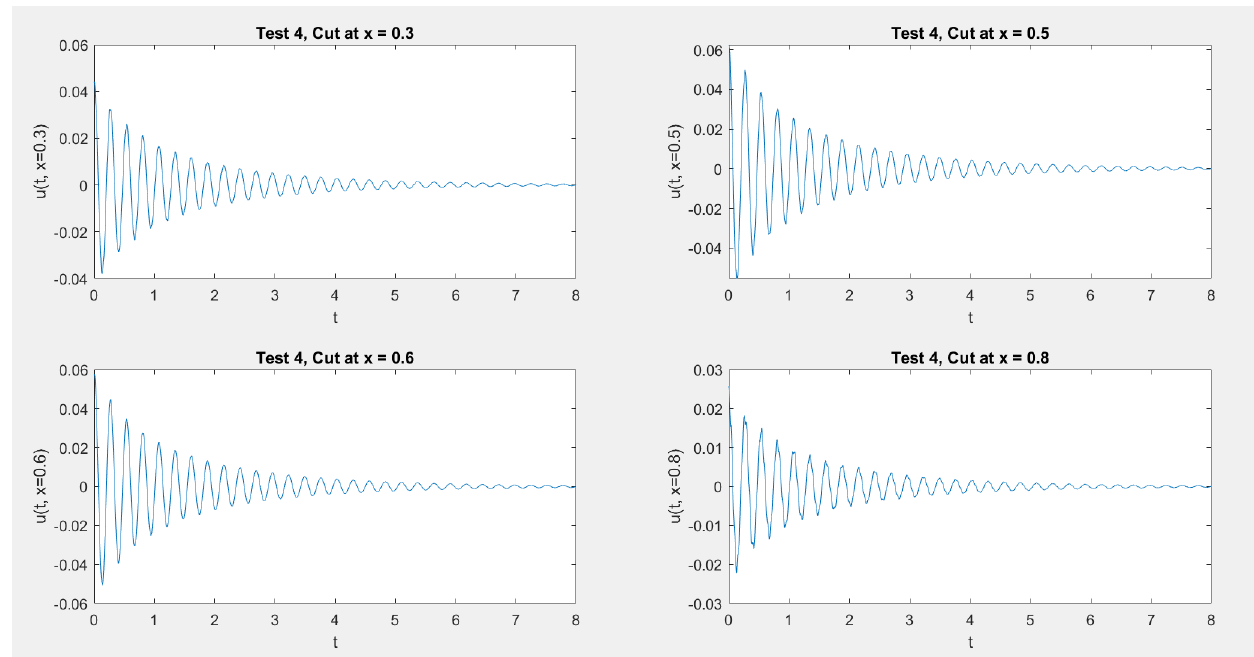
Figure 3. Test3: The solution u ( t ) at fixed values of x .